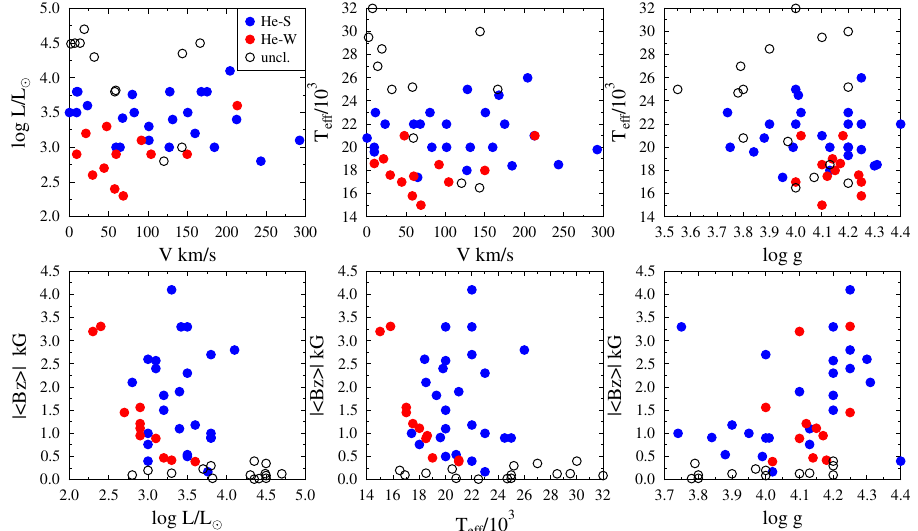
Figure 41. Magnetic B-type stars differentiated into He-weak (red points), He-strong (blue points) and He-unclassified (open black